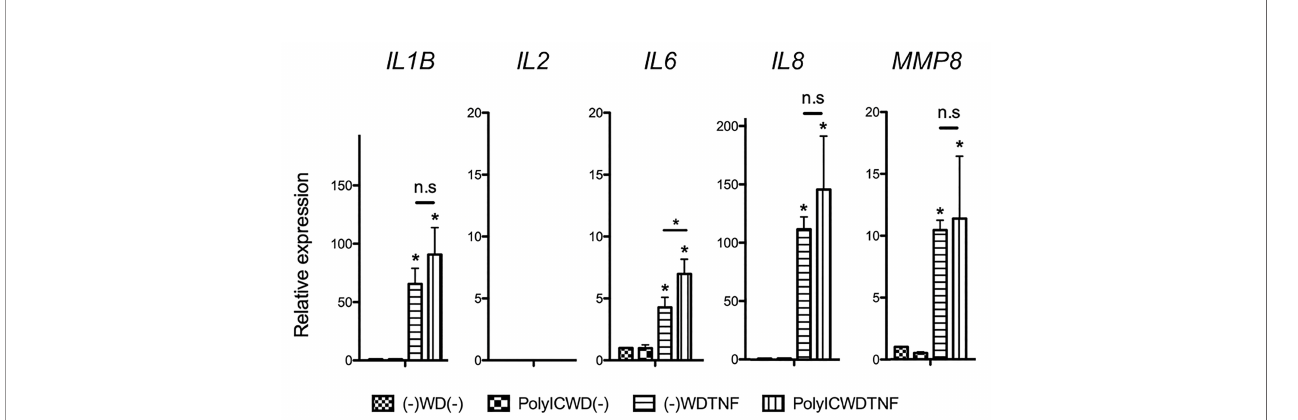
FIGURE 2 | Gene expressions after PolyIC – WD – TNF in MRC-5 cells. MRC-5 cells were initially treated with Poly (I:C) (10 µg/ml) for 24 h and were then washed and rested for 24 h before being secondarily treated with TNF a (10 ng/ml) for another 24 h. Poly (I:C) alone [PolyIC – WD-(-)] did not increase any of the gene expressions investigated, while TNF a alone [(-)-WD – TNF] variably induced the gene expressions of IL1B , IL6 , IL8 , and MMP8 , but not IL2 . Preexposure to Poly (I:C) signi fi cantly increased TNF a -induced IL6 expressions (P < 0.05) but not IL1B , IL8 , and MMP8 . N = 4. Values with * were de fi ned signi fi cant when compared to (-)-WD-(-) while *above bar were signi fi cant between two variables; n.s means not signi fi